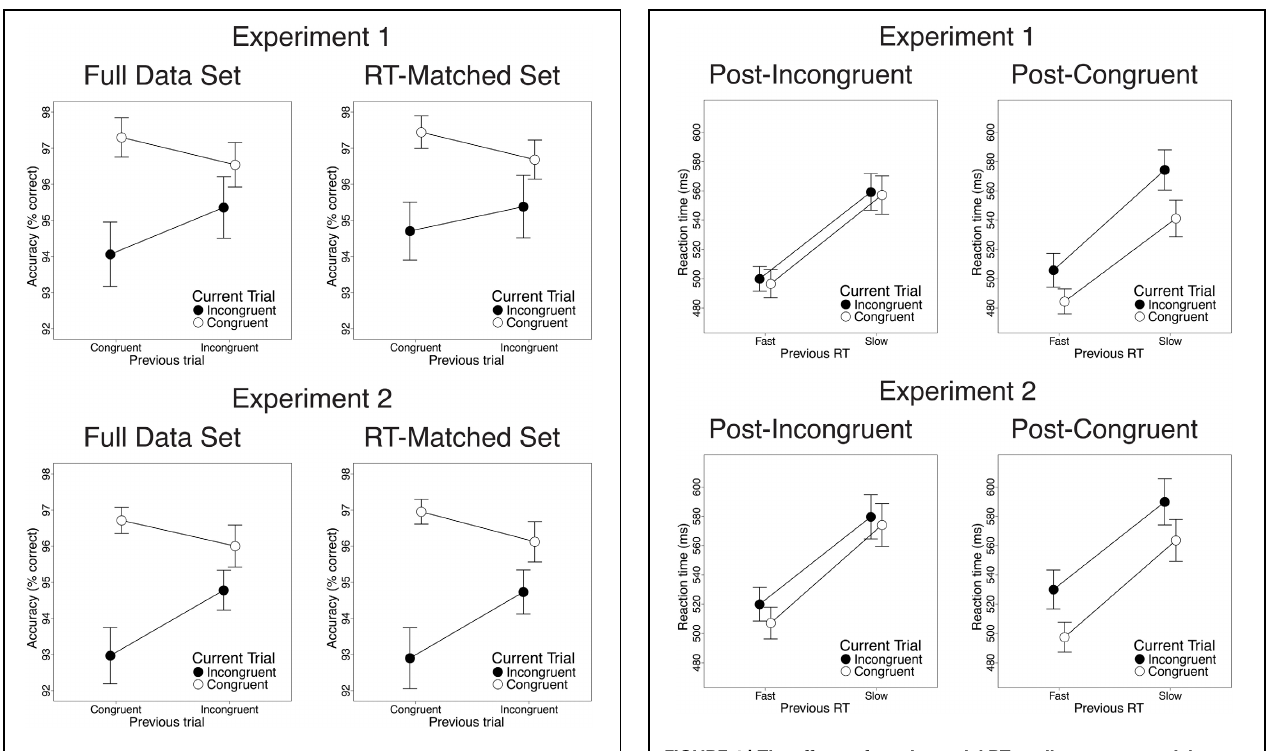
FIGURE 3 | Congruency sequence effects (CSEs) in the accuracy data. We observed significant CSEs in the full data set [Experiment 1: t ( 22 ) = 2 . 47, p = 0 . 02; Experiment 2: t ( 25 ) = 2 . 91, p = 0 . 007] and in the RT-matched data set [Experiment 1: t ( 22 ) = 1 . 94, p = 0 . 065; Experiment 2: t ( 25 ) = 3 . 27, p = 0 . 003]. CSEs did not differ across data sets [Experiment 1: t (